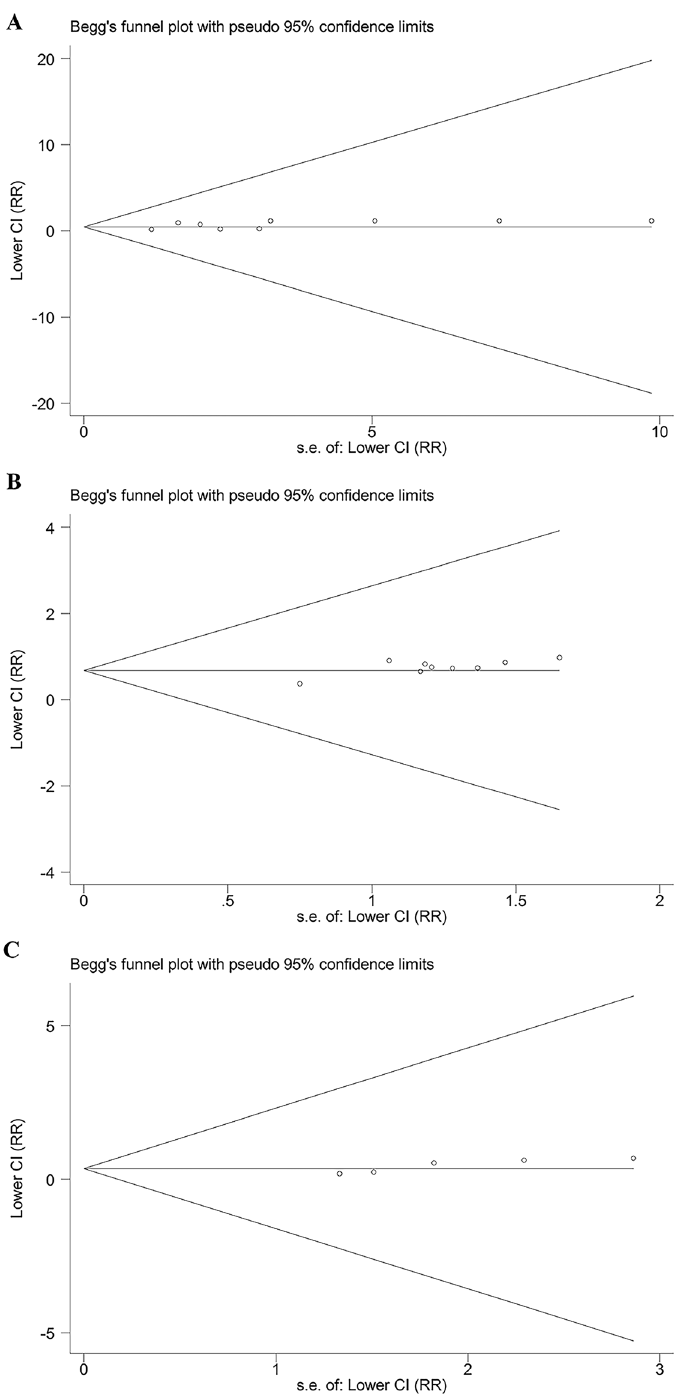
Figure 5. Begg’s funnel plots for assessing publication bias for ( A ) rs1800801; ( B ) rs11614913; ( C )